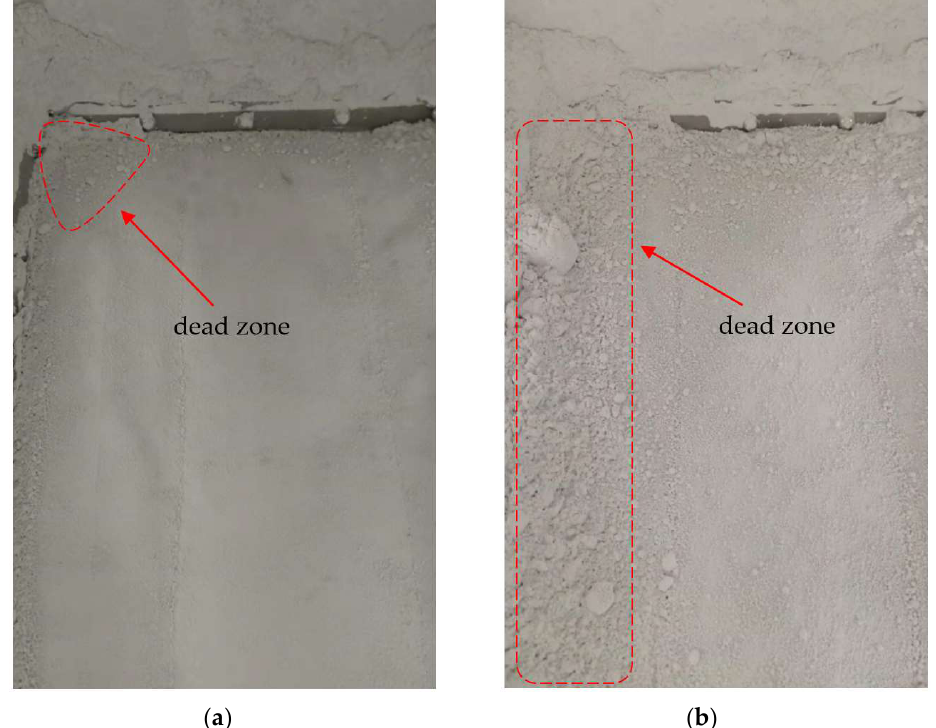
Figure 9. Effects of the two schemes for powder unloading. ( a ) Scheme 1; ( b ) Scheme 2.